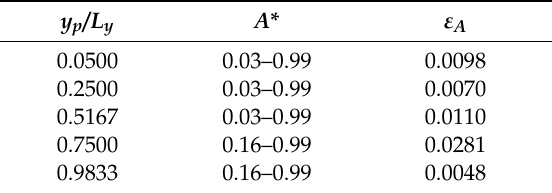
Figure 10. Plots of the P r of MMMs embedding cuboid nanoparticles as a function of A * for five di ff erent values of y p / L y . Table 3. Average prediction errors of the P r of Figure 10 using the proposed model evaluated over five values of the y p / L y